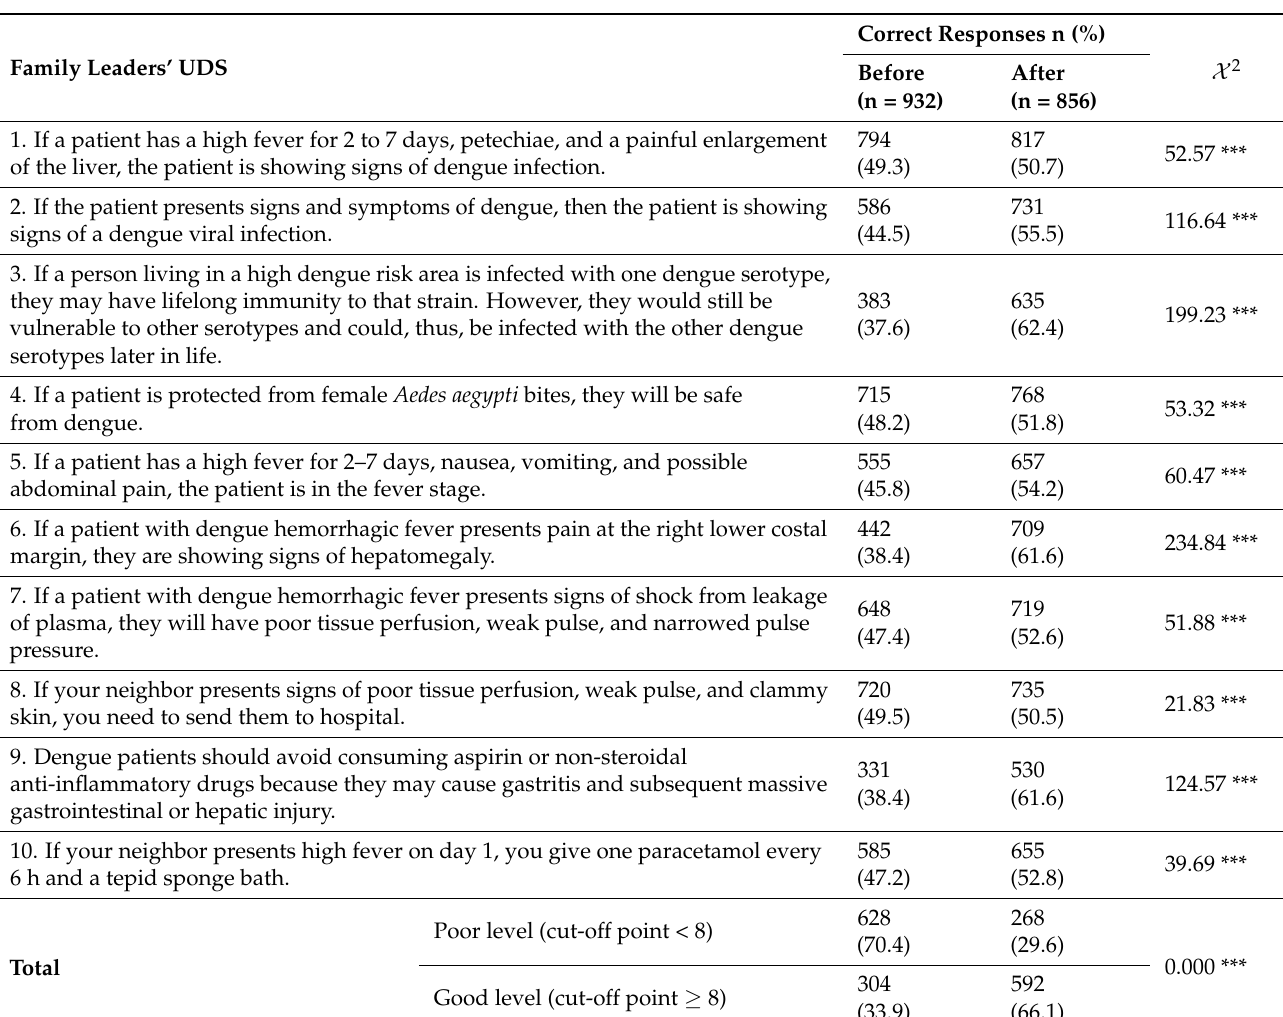
Table 6. Comparison of correct response rates regarding the UDS for family leaders before and after implementation of the training